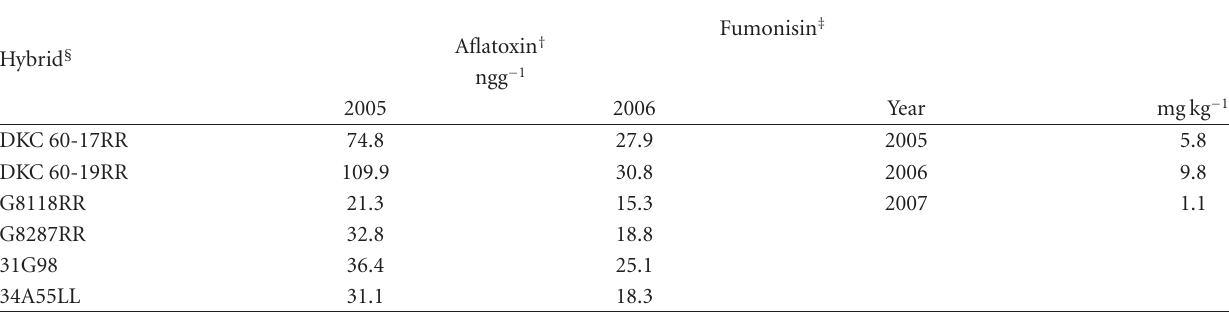
Table 7: Combined Mean Aflatoxin and Fumonisin Contamination of Herbicide Tolerant Corn Hybrids Grown With and Without Herbicide Application at Stoneville,